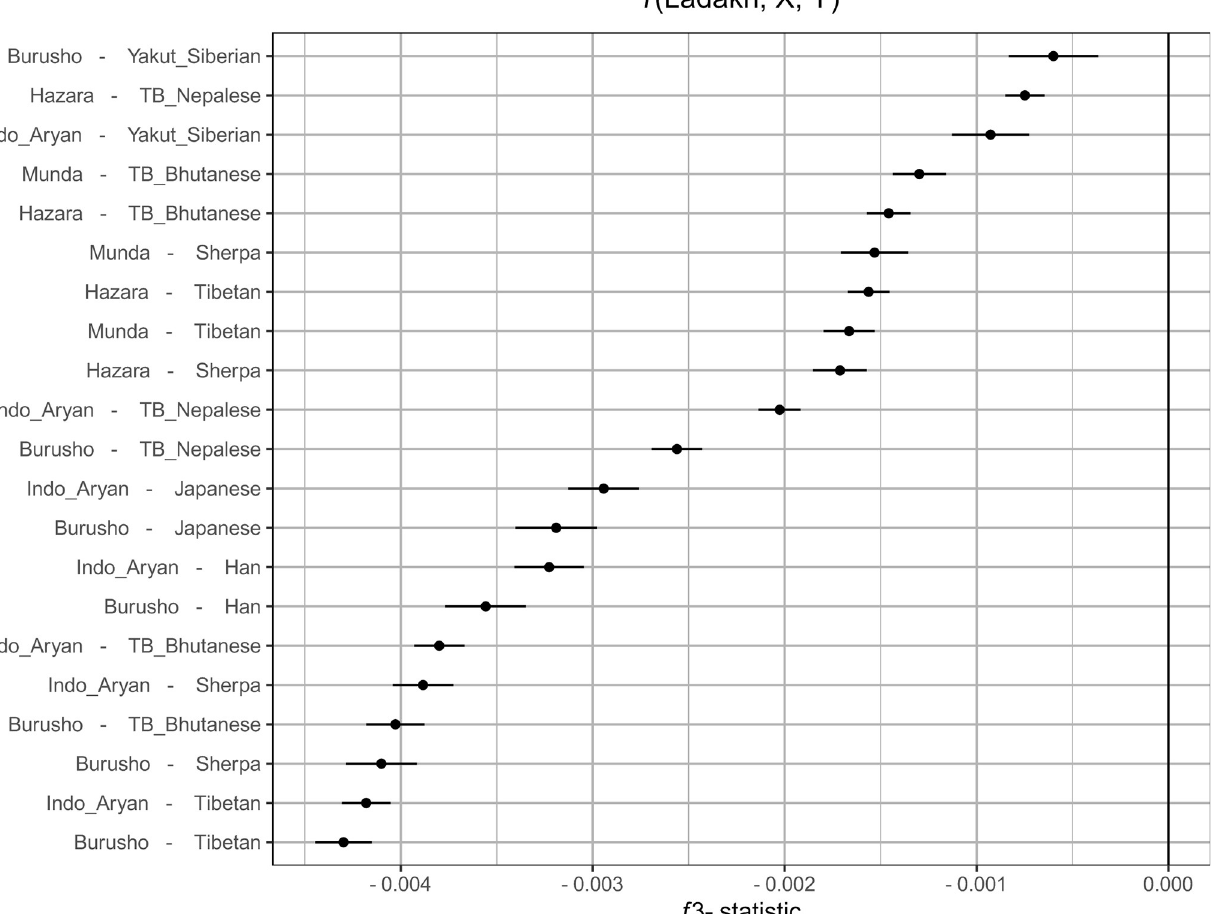
PLOS ONE | https://doi.org/10.1371/journal.pone.0269671 September 20,